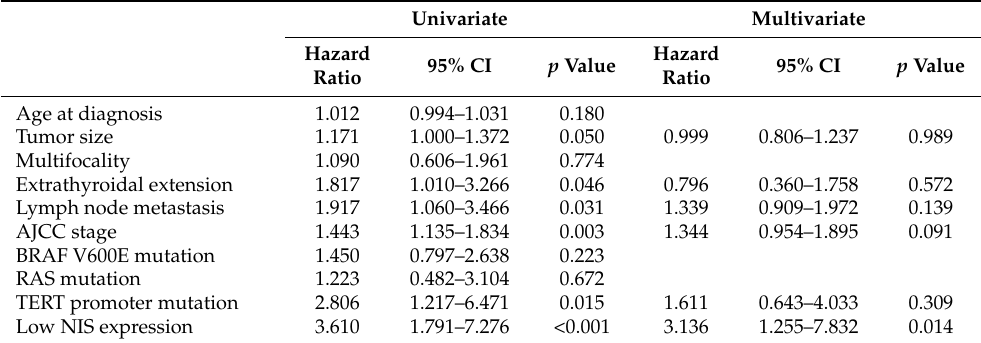
Table 2. Cox regression analysis of recurrence-free survival in the TCGA-THCA patient cohort.